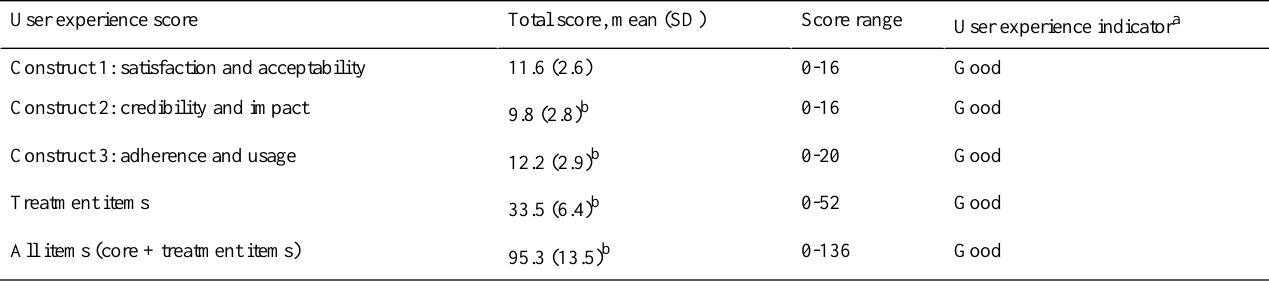
Table 9. Breathe respondents’user experiences (n=81) presented by user experience construct, treatment items, and all items total scores from the User Experience Questionnaire for Internet-based